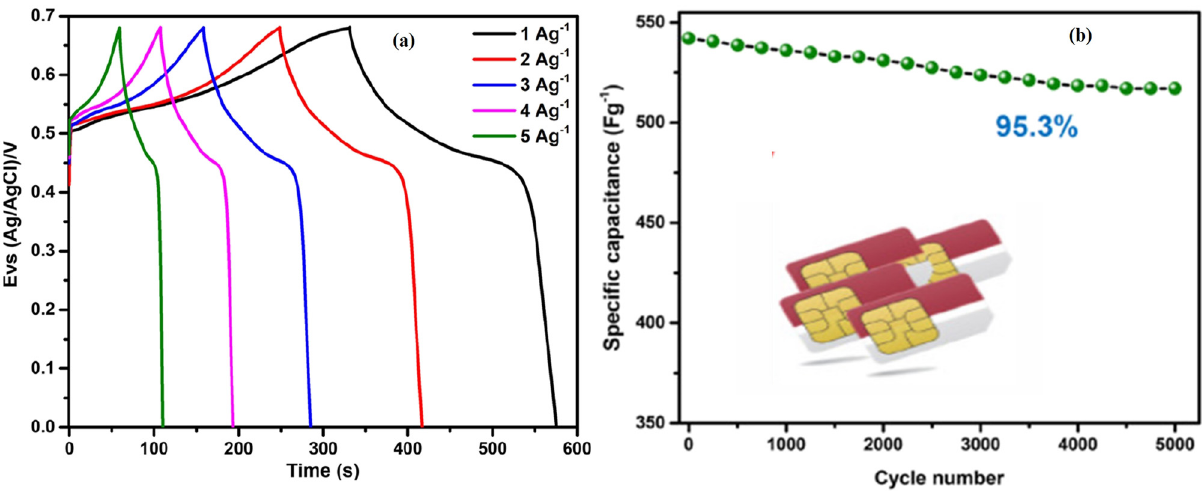
Figure 33: ( a ) GCD curves and ( b ) stability of copper oxide recovered from SIM cards. Copied with permission from ref. [ 296 ] ; Elsevier, 2020.